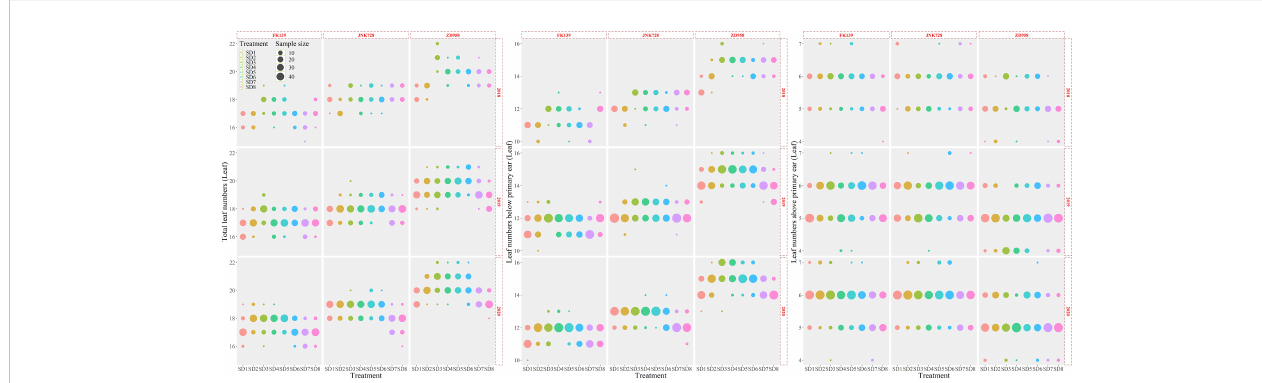
FIGURE 2 Variation observed in leaf counts relative to sowing dates. A, variation in TLN; B, variation in LB; C, variation in LA.